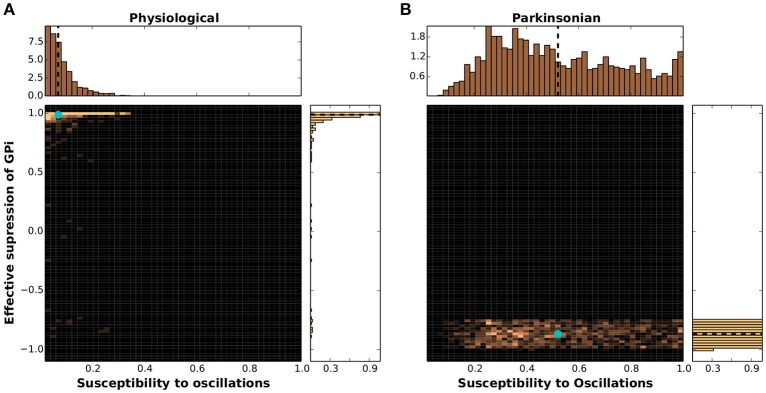
Clustering of networks in dynamical feature space. (A) 2D histogram of physiological networks projected into the feature space spanned by susceptibility to oscillations (SO) and GPi suppression (GS), mean indicated by a cyan marker. Margins give the corresponding 1D histograms, with means indicated by black dashed lines. (B) As in (A) but for parkinsonian networks.